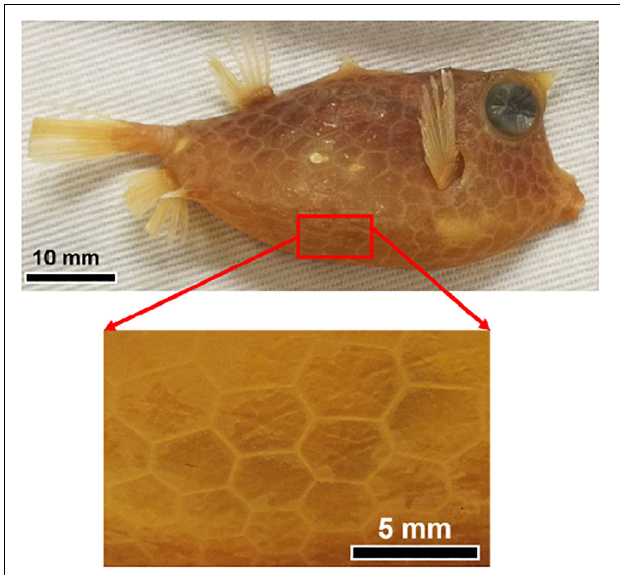
FIGURE 3 | Boxfish ( Lactoria cornuta ) scale structures (Miranda et al., 2019).